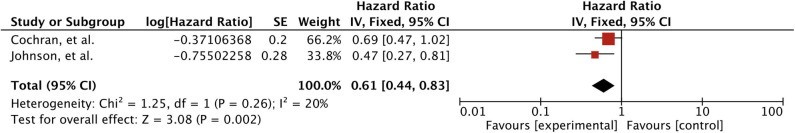
Forest plot of meta-analysis of overall survival (OS) for treatment comparison (TKIs vs. non-TKIs) involving SRS subgroup in the management of brain metastases from renal cell carcinoma (RCC).